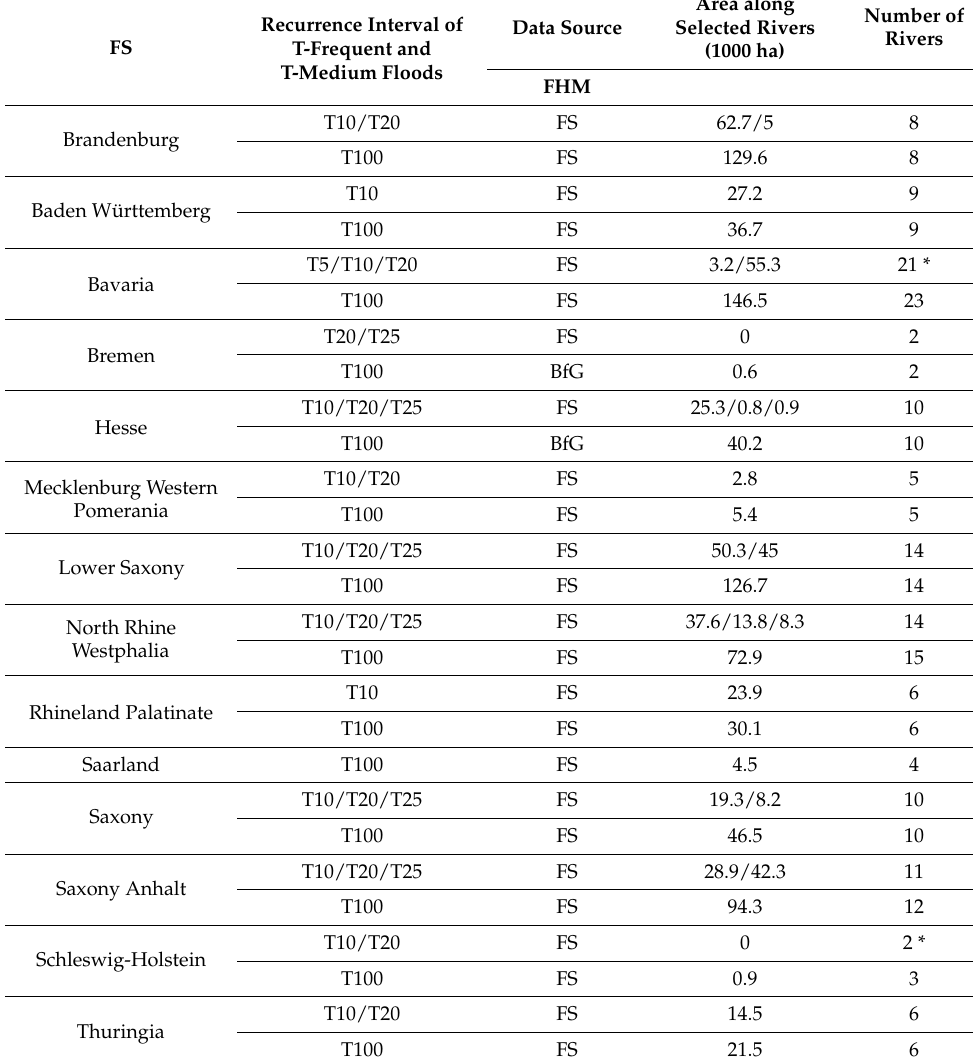
Table 2. Characteristics of flood hazard maps (FHM) applied in this study, collected from federal states (FS) or BfG (available under https://geoportal.bafg.de/download/opendata/ ueberflutungstiefen/servicefeed.xml). The number of rivers investigated in T-frequent or T-medium floodplains is the same for most FS, except for * when the area is below 5 ha and in Saxony-Anhalt with information on one more river for T-medium floodplains. Area along Number of Recurrence Interval of Data Source Selected Rivers Rivers FS T-Frequent and (1000 ha) T-Medium Floods FHM Brandenburg